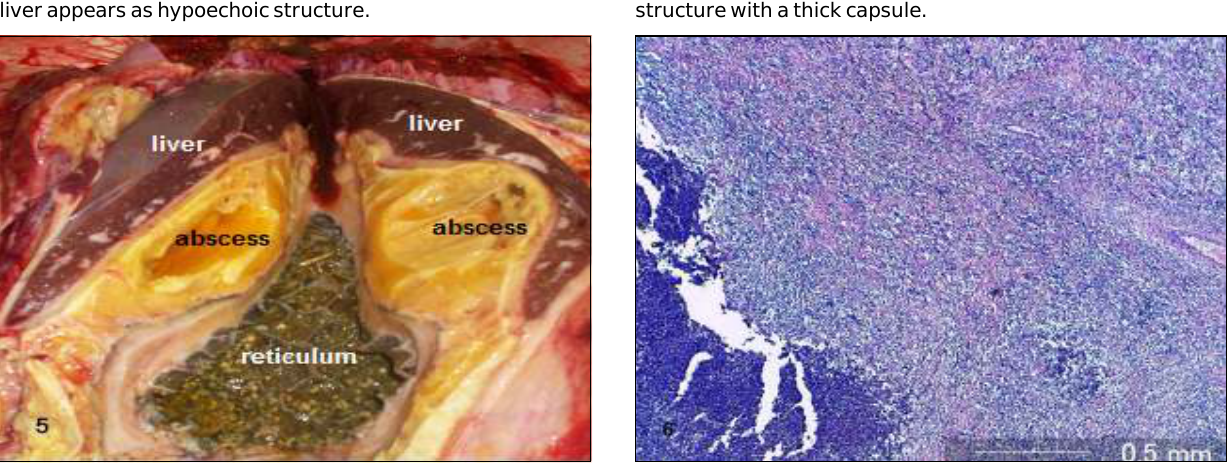
Figure-6: Histopathology of an abscess showing a necrotic center containing leukocytes, hepatocytes and cellular debris. H&E x